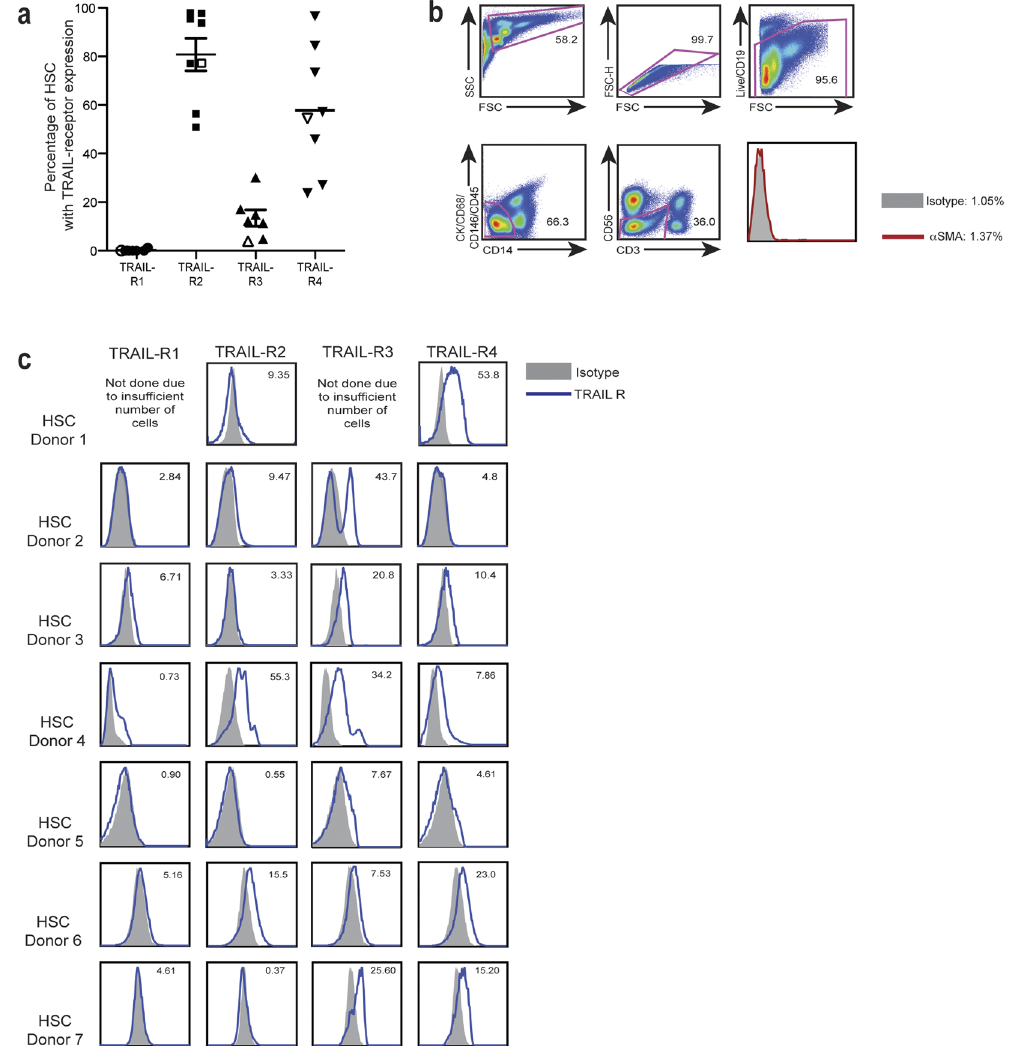
Figure 2. Expression of pro-apoptotic TRAIL-R2 and anti-apoptotic TRAIL-R3 and TRAIL-R4 on hHSC. ( a ) Percentage expression of TRAIL-R1, TRAIL-R2, TRAIL-R3 and TRAIL-R4 on in vitro cultured hHSC (filled symbols) and LX2 (open symbols). ( b ) Gating strategy of freshly isolated primary human HSC. All other intrahepatic populations were sequentially gated out (CD19, cytokeratin, CD68, CD146, CD14, CD45, CD3, CD56 shown here excluded from pink gates, + / − CD45 not shown) to identify quiescent hHSC, then confirmed to be negative for α SMA (red line, final histogram). ( c ) ex vivo expression of TRAIL-R1–4 on freshly isolated hHSC (blue) against matched isotype control (grey) from seven